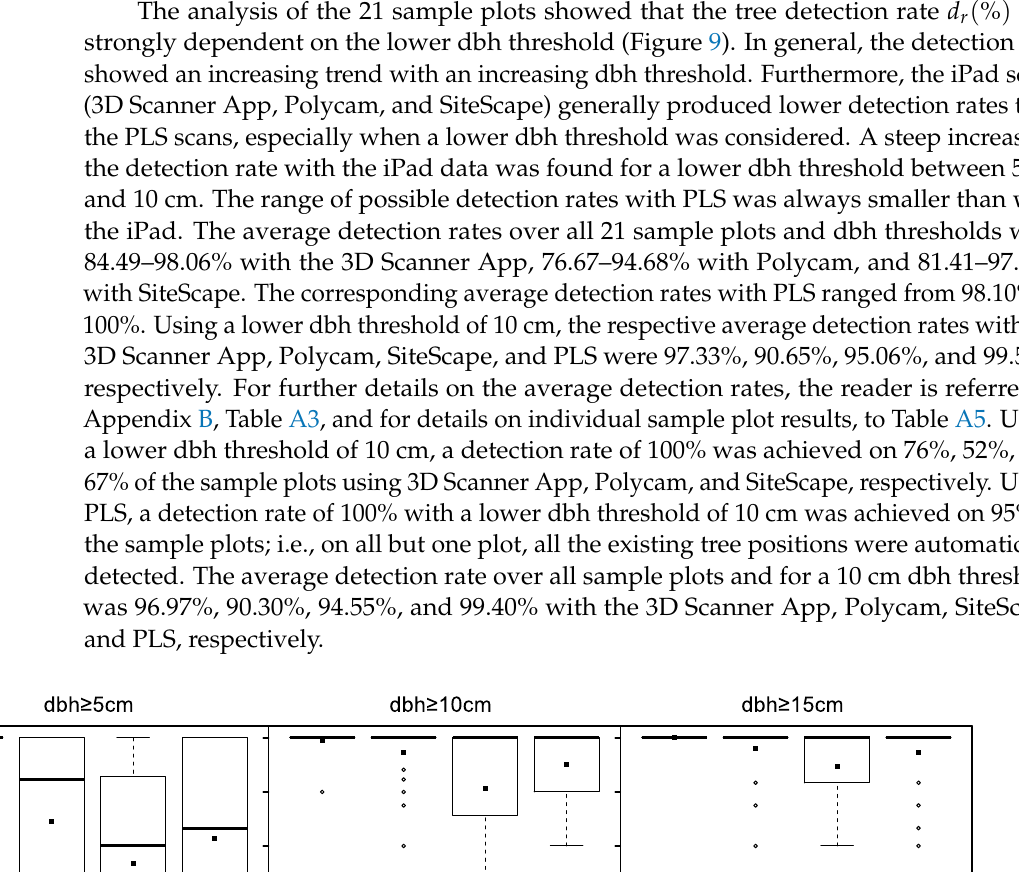
Figure 10. Distribution of commission errors for PLS/iPad and lower dbh thresholds. Black squares represent average detection rates over all sample plots. The overall accuracy rates 𝑎𝑐𝑐(%) as a joint quality criterion of the detection and commission rates, are presented in Figure 11. The overall accuracy showed similar trends as the detection rates dependent on a changing lower dbh threshold. The average overall accuracy across all 21 sample plots and dbh thresholds was 81.80–94.76% with the 3D Scanner App, 76.39–93.89 with Polycam, and 80.21–95.11% with SiteScape. The average overall accuracy with PLS varied between 95.07% and 95.27%. Using a lower dbh thresh- old of 10 cm, the average overall accuracies with the 3D Scanner App, Polycam, SiteScape, and PLS were 94.37%, 90.18%, 93.62%, and 95.71%, respectively. For further details on average overall accuracies, the reader is referred to Appendix B, Table A3, and for the details per sample plot, to Table A5. The overall accuracies with a lower dbh threshold of